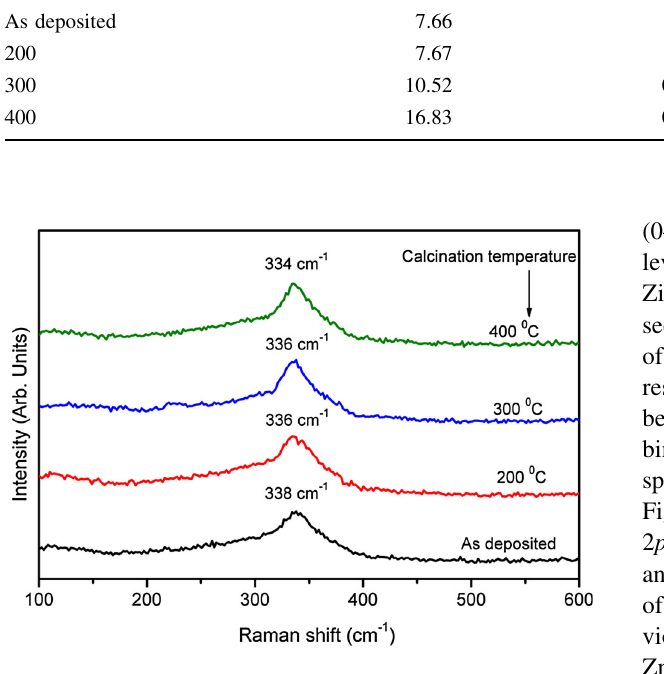
Fig. 2 Raman spectrum of kesterite CZTS of as deposited and after calcination CZTS thin films at different temperatures. The observed featured peaks are at 344 , 336 , and 338 cm - 1 and indicates that CZTS has synthesized without any impurity